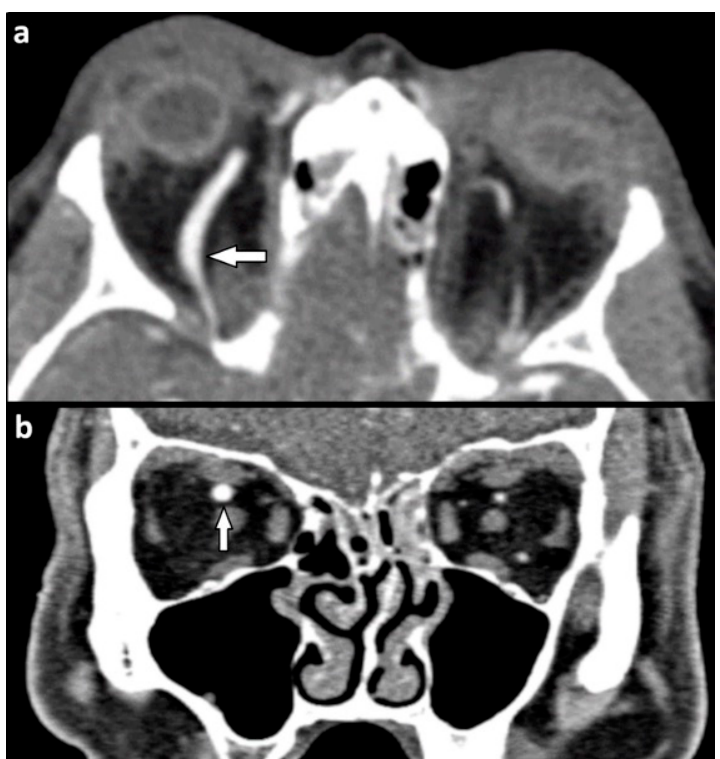
Figure 6. Prominent right ophthalmic vein (white arrows). Compared to the contralateral vein, the vessel appears engorged. CE-MSCT, soft tissue window. ( a ) Axial reformation. ( b ) Engorged superior ophthalmic vein and exophthalmos of the right globe hinting at post-traumatic CCF (CE-MSCT = contrast-enhanced multi-slice CT, CCF = carotis-cavernous fistula). A direct CCF was identified in six (5.9%) individuals. Intraorbital foreign bodies were identified in extraocular muscles, the optic nerve, and the ocular globe in three individuals (3%) (Figure 7).